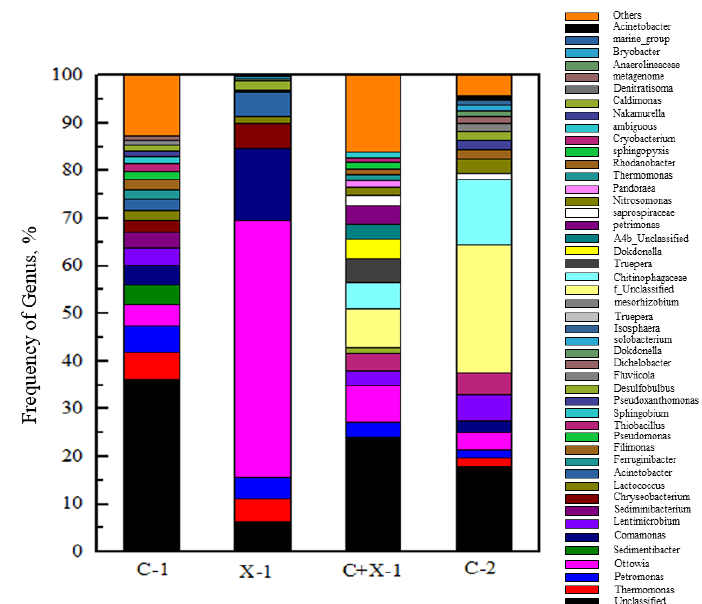
Figure 10. The distribution of microbial communities at genus